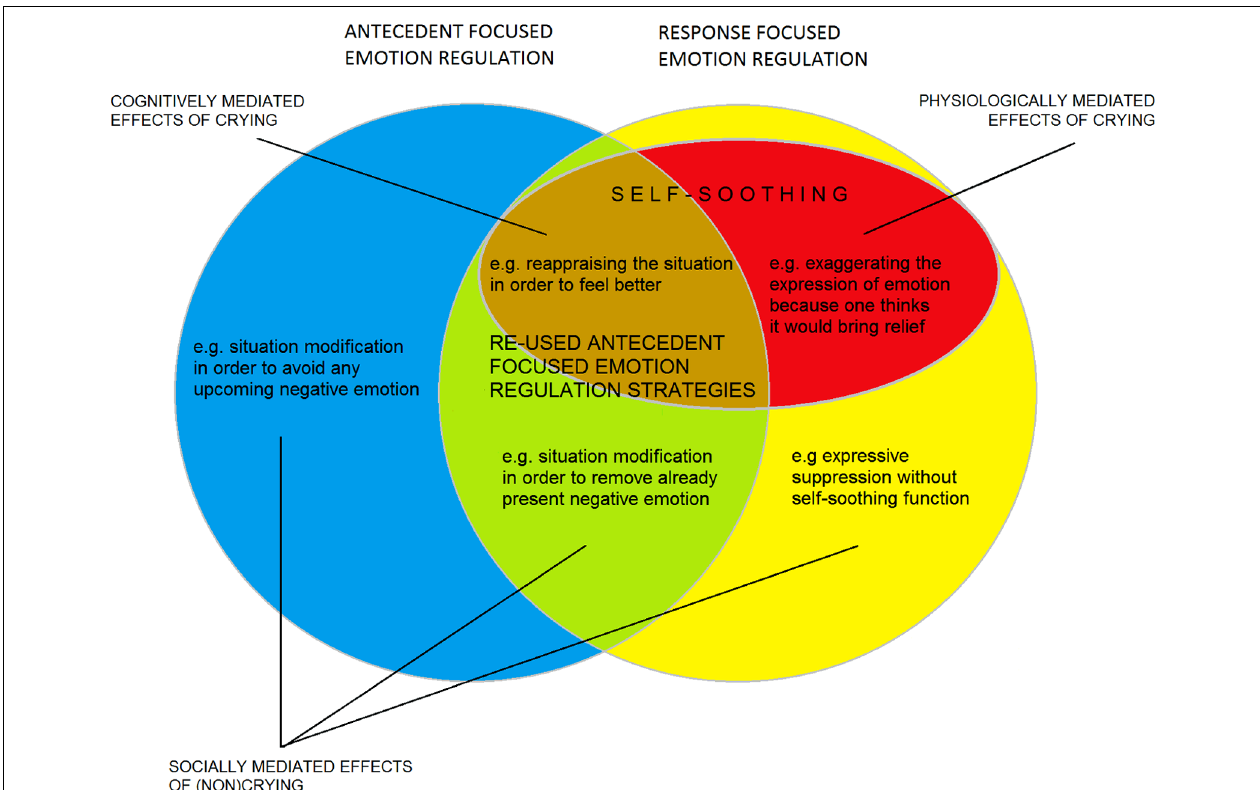
FIGURE 1 | Self-soothing in relation to antecedent and response-focused emotion regulation